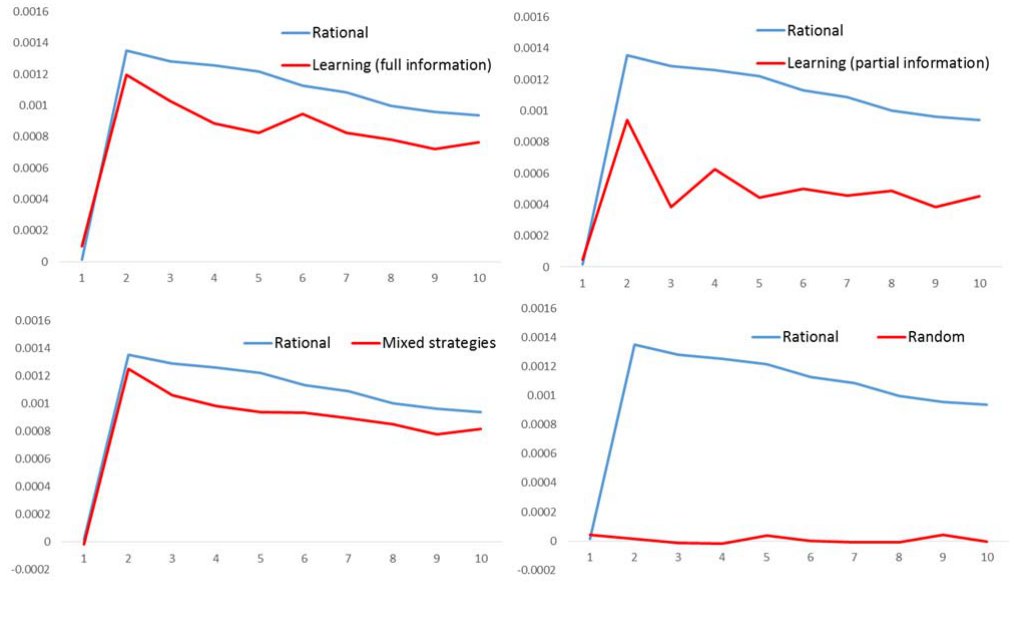
Figure 3. Responses of output to innovation in demand